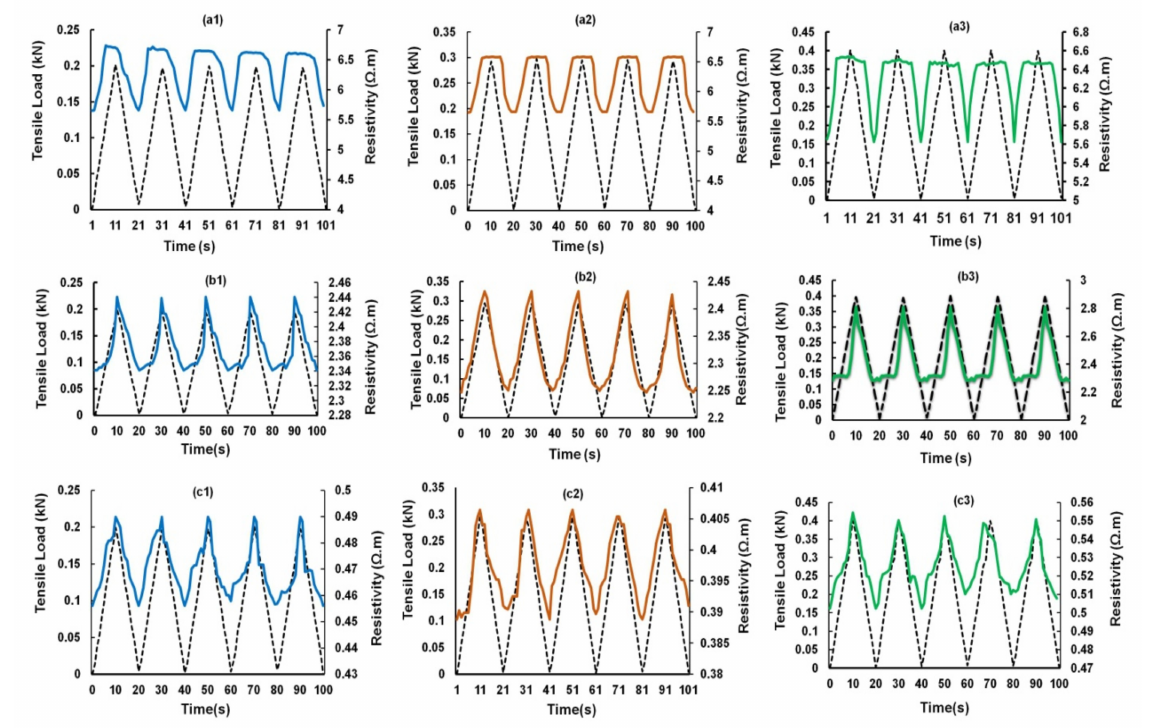
Figure 9. Change of electrical resistance with cyclic tensile load of CF reinforced cementitious compos- ites at different peak loads containing 0.25% CF ( a1 – a3 ), 0.50% CF ( b1 – b3 ) and 0.75% CF ( c1 – c3 ).